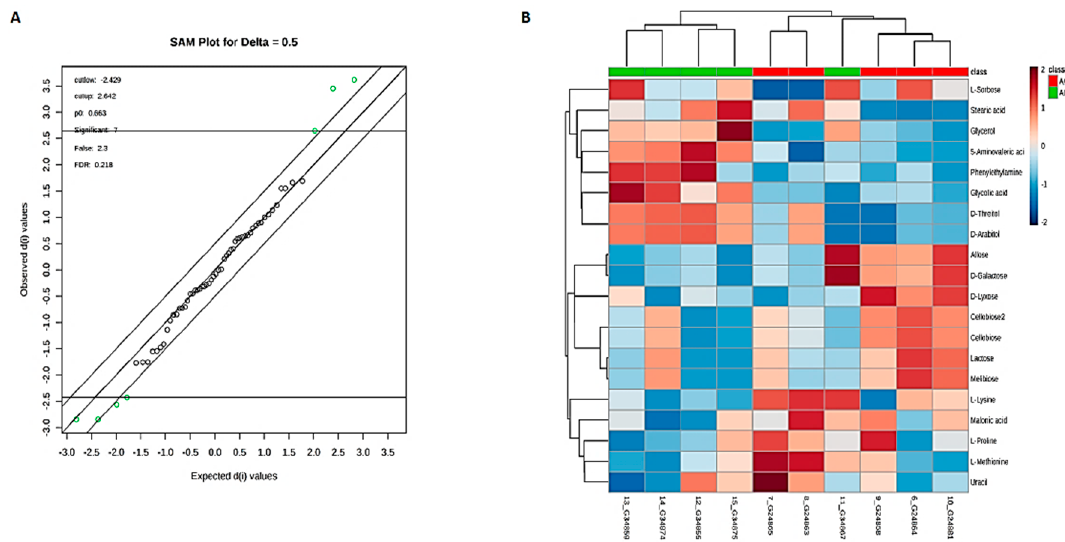
Figure 7. Significance analysis of microarray (SAM) plot ( A ) (Delta score = 0.5, metabolites highlighted in green are significant). Significant changes in metabolites are expressed as a heat map ( B ) in aging groups. (AC) Aging control group, (AP) Aging probiotic group.